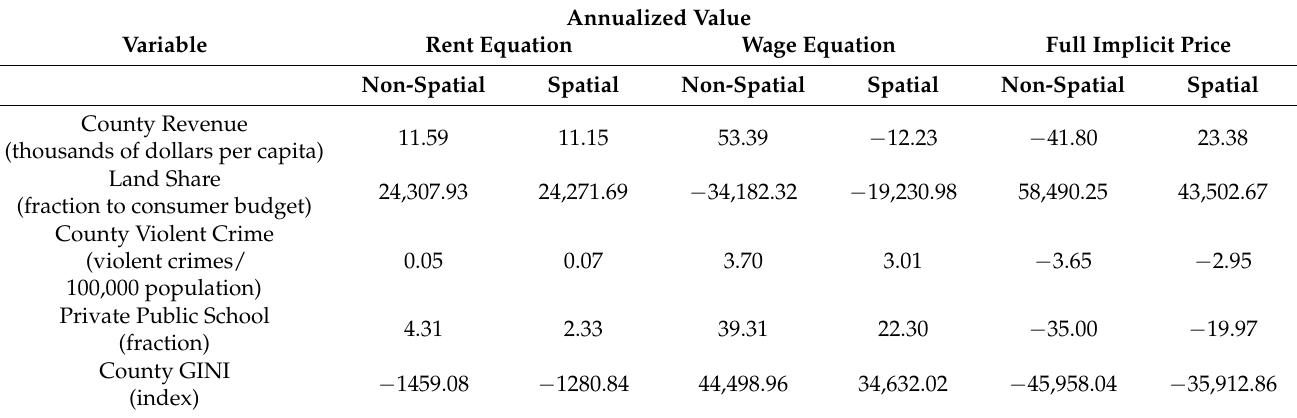
Table 6. Annualized values based on non-spatial and spatial models for the